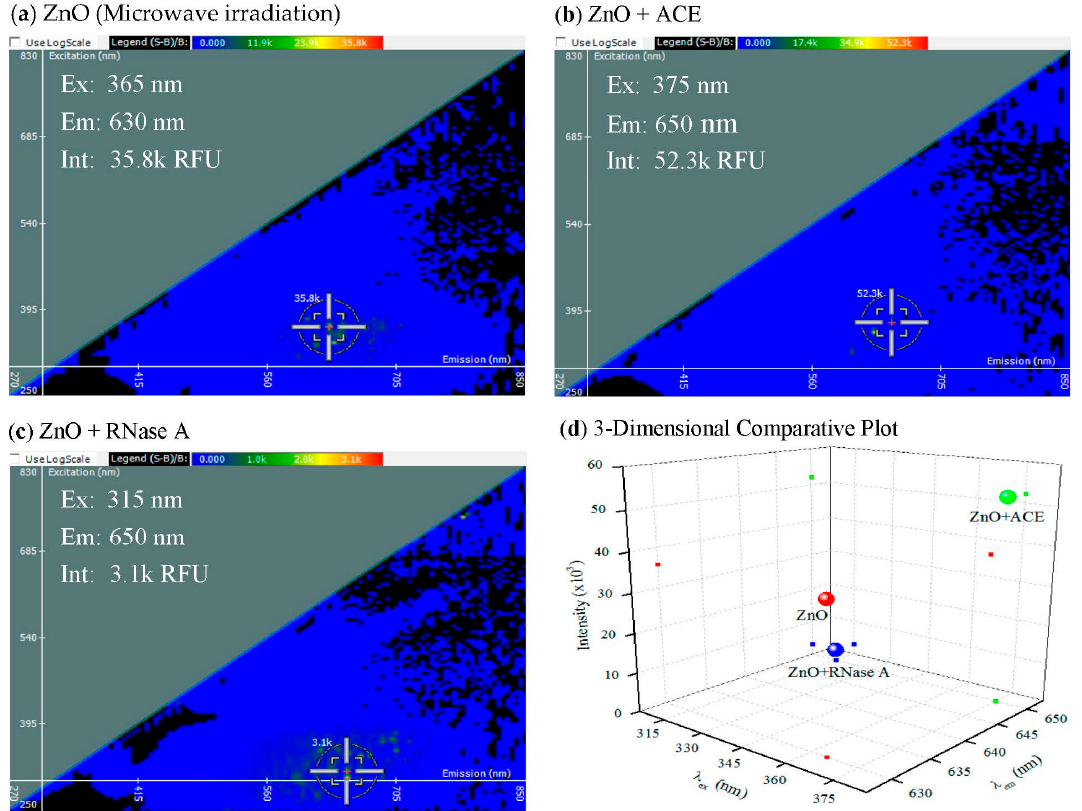
Figure 2. 2-D FDS of ( a ) ZnO nanoparticles synthesized by microwave irradiation; ( b ) ACE bound to microwave irradiation ZnO nanoparticles; and ( c ) ribonuclease A (RNase A) bound to microwave irradiation ZnO nanoparticles; The ( d ) 3-dimensional comparative plot of the three ZnO nanoparticle interactions.